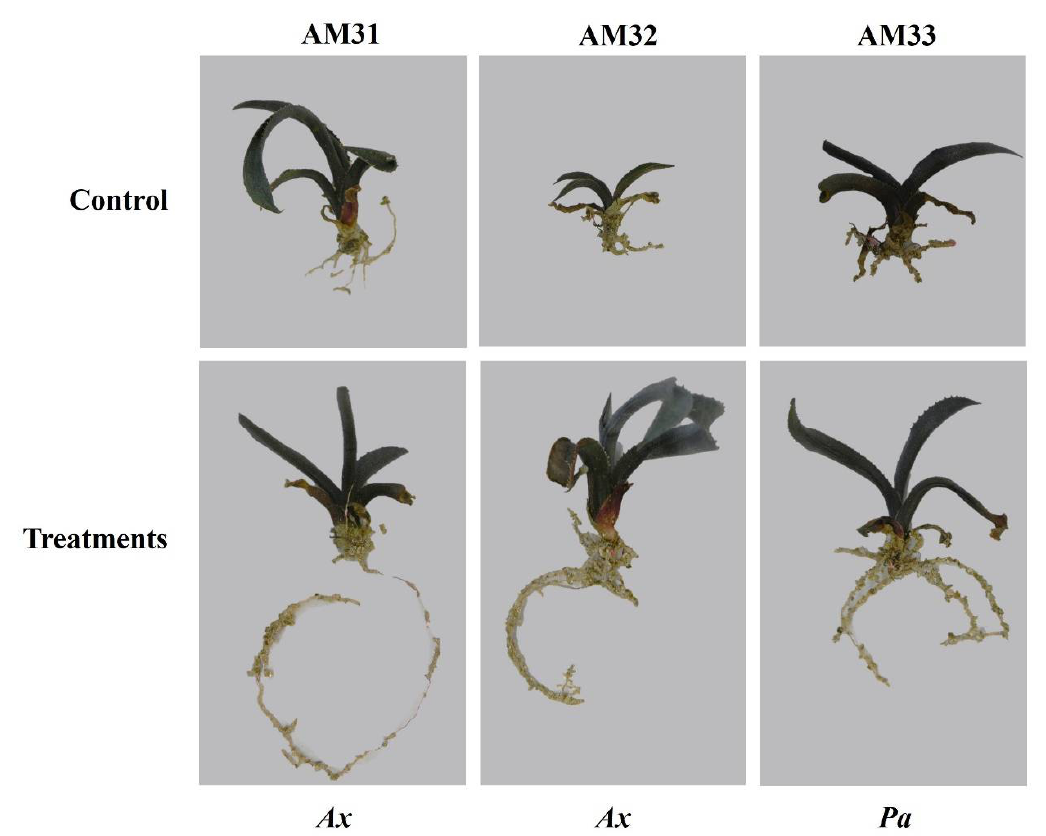
Figure 6. Response of A. marmorata clonal lines to endophytic bacteria inoculation. The figure summarizes the best treatment between bacterial inoculation and control, where A. xylosoxidans was the best treatment for AM31 and AM32, and P. aeruginosa was best for